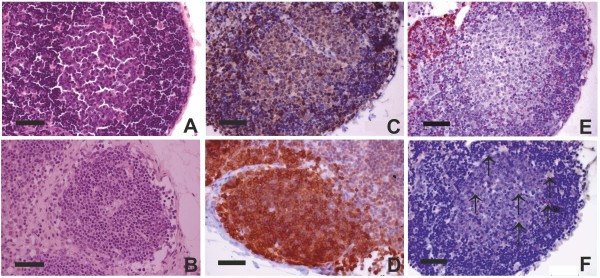
Follicular hyperplasia. A. Enlarged follicle with a light germinal centre (LAE442, 3 months, H&E, × 400). B. Physiological follicle (Control group, H&E, × 400). C. B-cells demonstrate a clear expression of CD79α (IHC method, × 4 00). D. B cells in a physiological follicle (IHC method, × 400). E. CD3 + T-cells presented in follicles (LAE442, 3 months, IHC method, × 400). F. Single CD68+ macrophages presented in follicles (arrows) (LAE442, 3 months, IHC method, × 400).